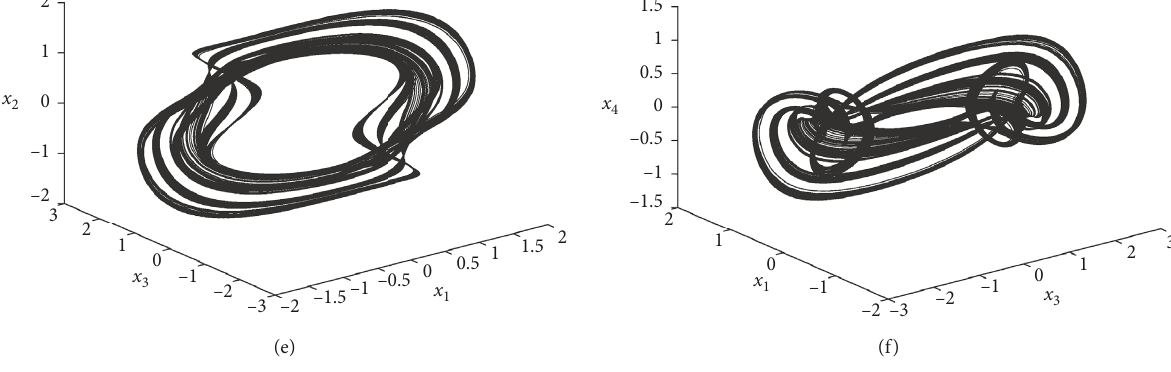
Figure 14: Quasiperiodic motion occurs when b